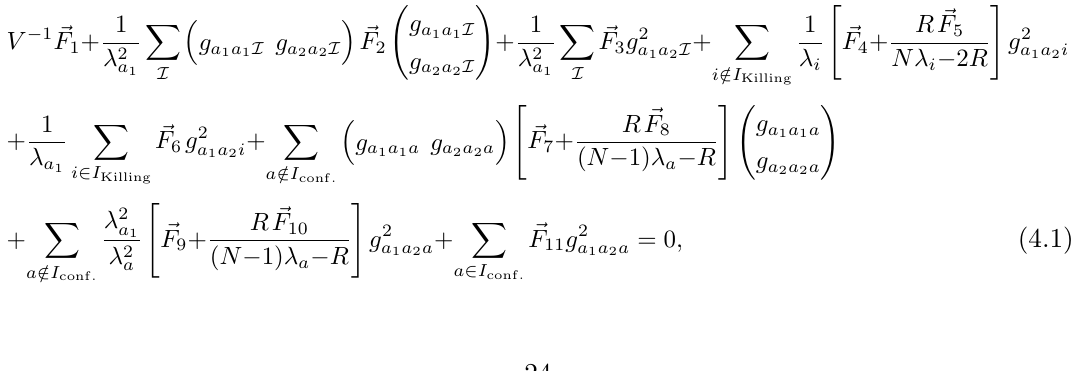
p j (cid:21) (cid:0) 1 V as we vary (cid:21) I =(cid:21) a for closed Einstein manifolds a 1 1 a 1 I 1 1 1 and (cid:21) I (cid:21) (cid:21) I 1 1